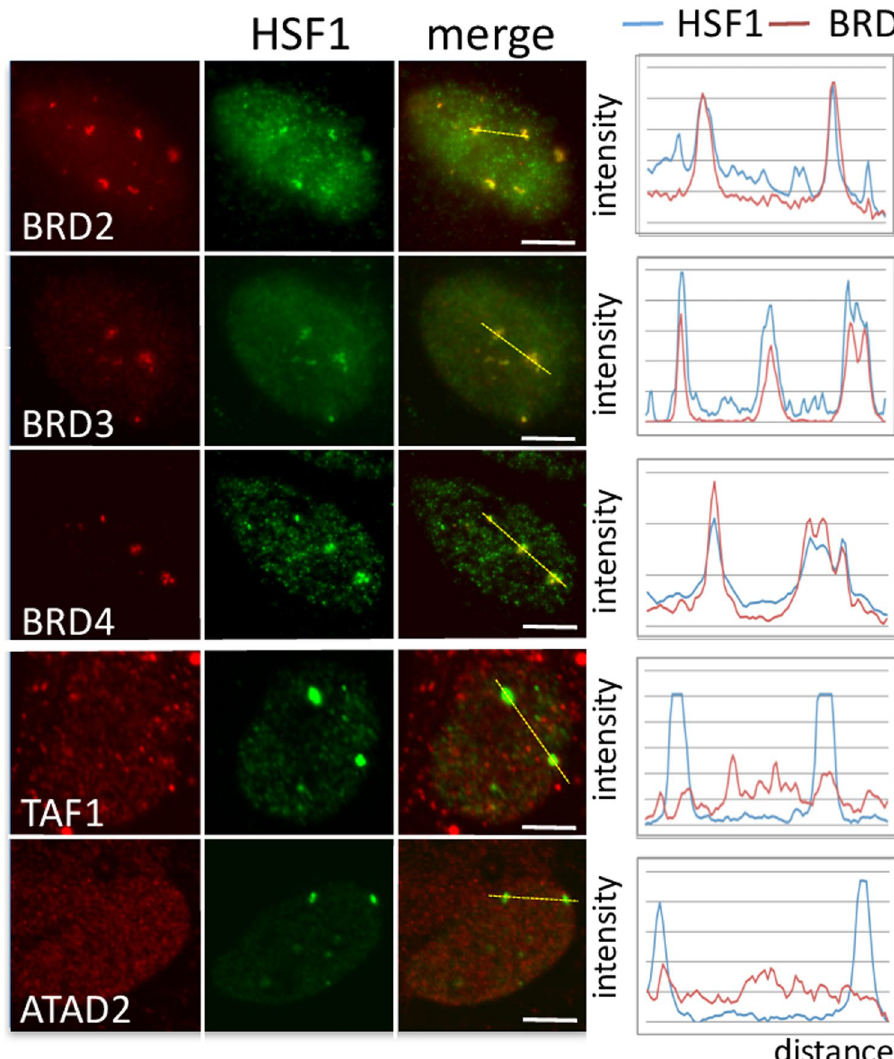
Figure 5. Specific Bromodomain-containing proteins are recruited to the 9q12 locus in stressed HeLa cells. Bromodomain containing proteins (green signals) are co-detected with HSF1 (red signals) by immunofluorescence on stressed cells. Endogenous BRD2, BRD3 and BRD4 are enriched at nSBs together with endogenous HSF1 (green signals) while TAF 250 and ATAD2 are not. Absence of TAF1 and ATAD2 enrichment at the 9q12 locus was confirmed by comparative analysis of TAF1 or ATAD2 and HSF1 fluorescence profiles. Scale bar = 5 µ